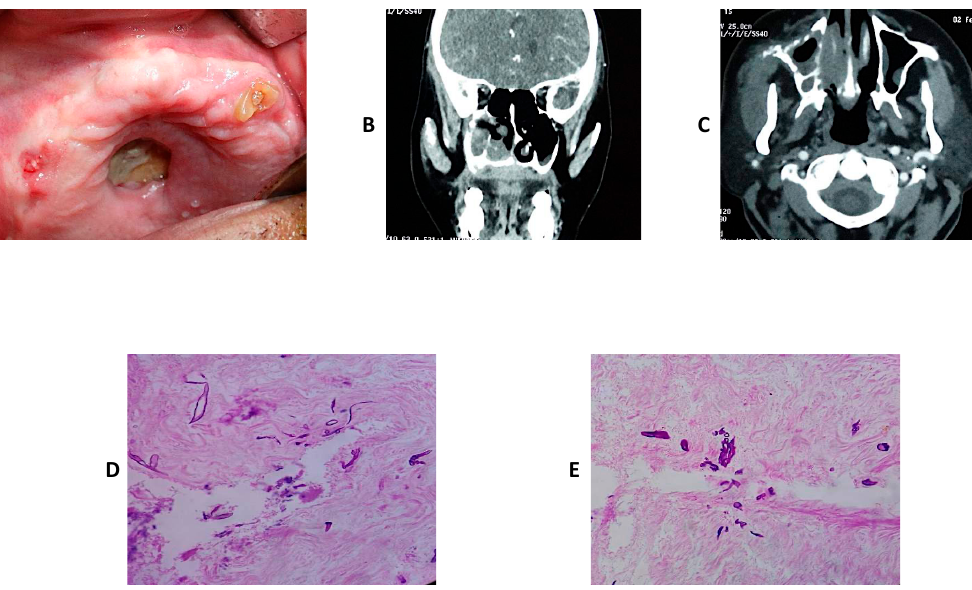
Figure 5. An edentulous maxilla with an exposed necrotic bone in the palate and draining sinus in the right canine region ( A ). The axial ( B ) and coronal ( C ) slices of contrast enhanced CT scans of the maxilla respectively showing bone destruction, sequestrum formation, involvement of the right turbinate and sinus opacification. Histopathological slides (H&E staining) showing non-septate fungal hyphae consistent with diagnosis of mucormycosis ( D , E